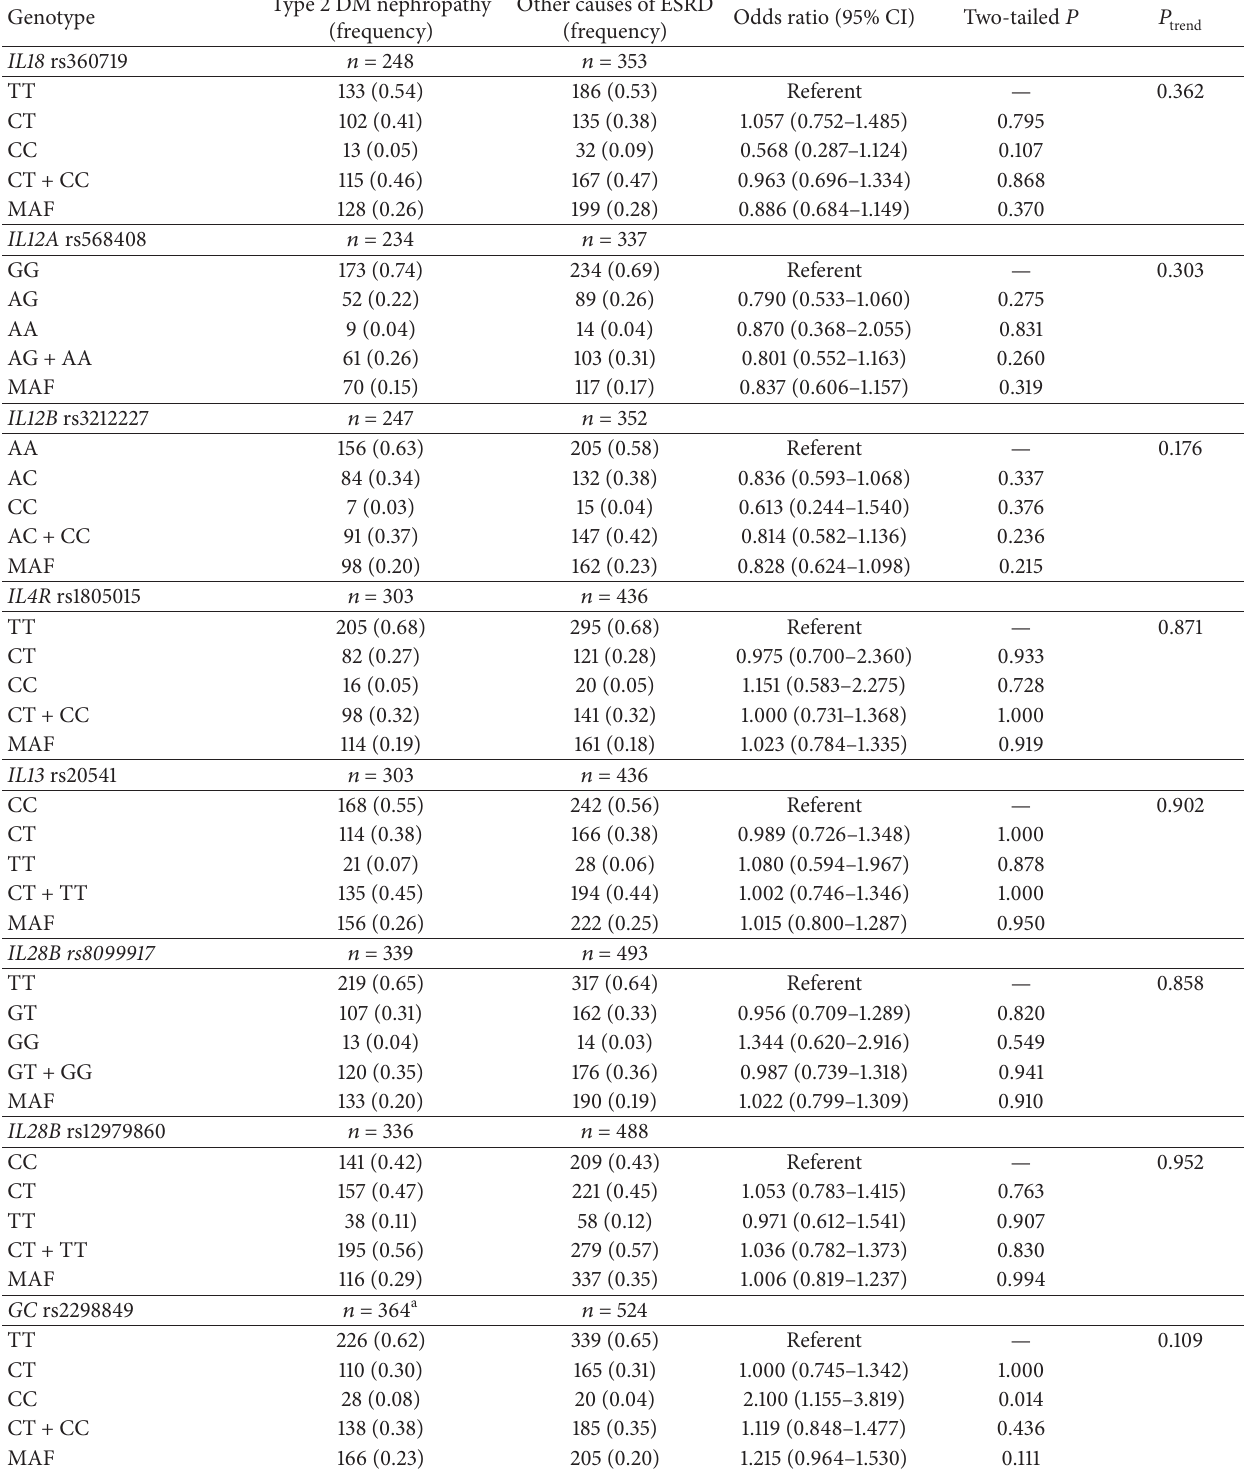
Table 5: Comparison of the distribution of polymorphic variants of tested genes between ESRD patients treated with hemodialysis due to type 2 DM nephropathy and the most common causes of ESRD other than type 2 DM nephropathy (chronic glomerulonephritis, chronic tubulointerstitial nephritis, and hypertensive